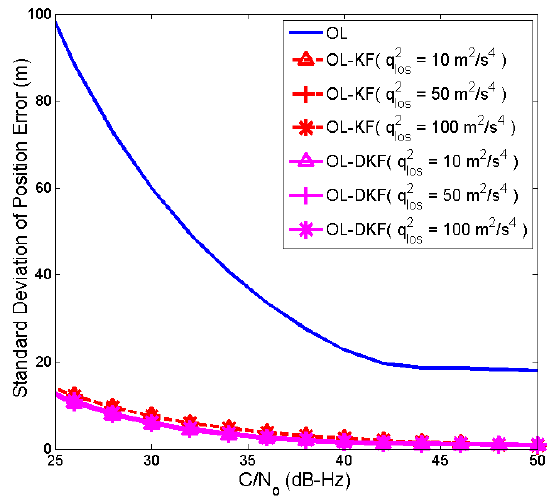
Figure 12. Standard deviation of the position error (6 sats).